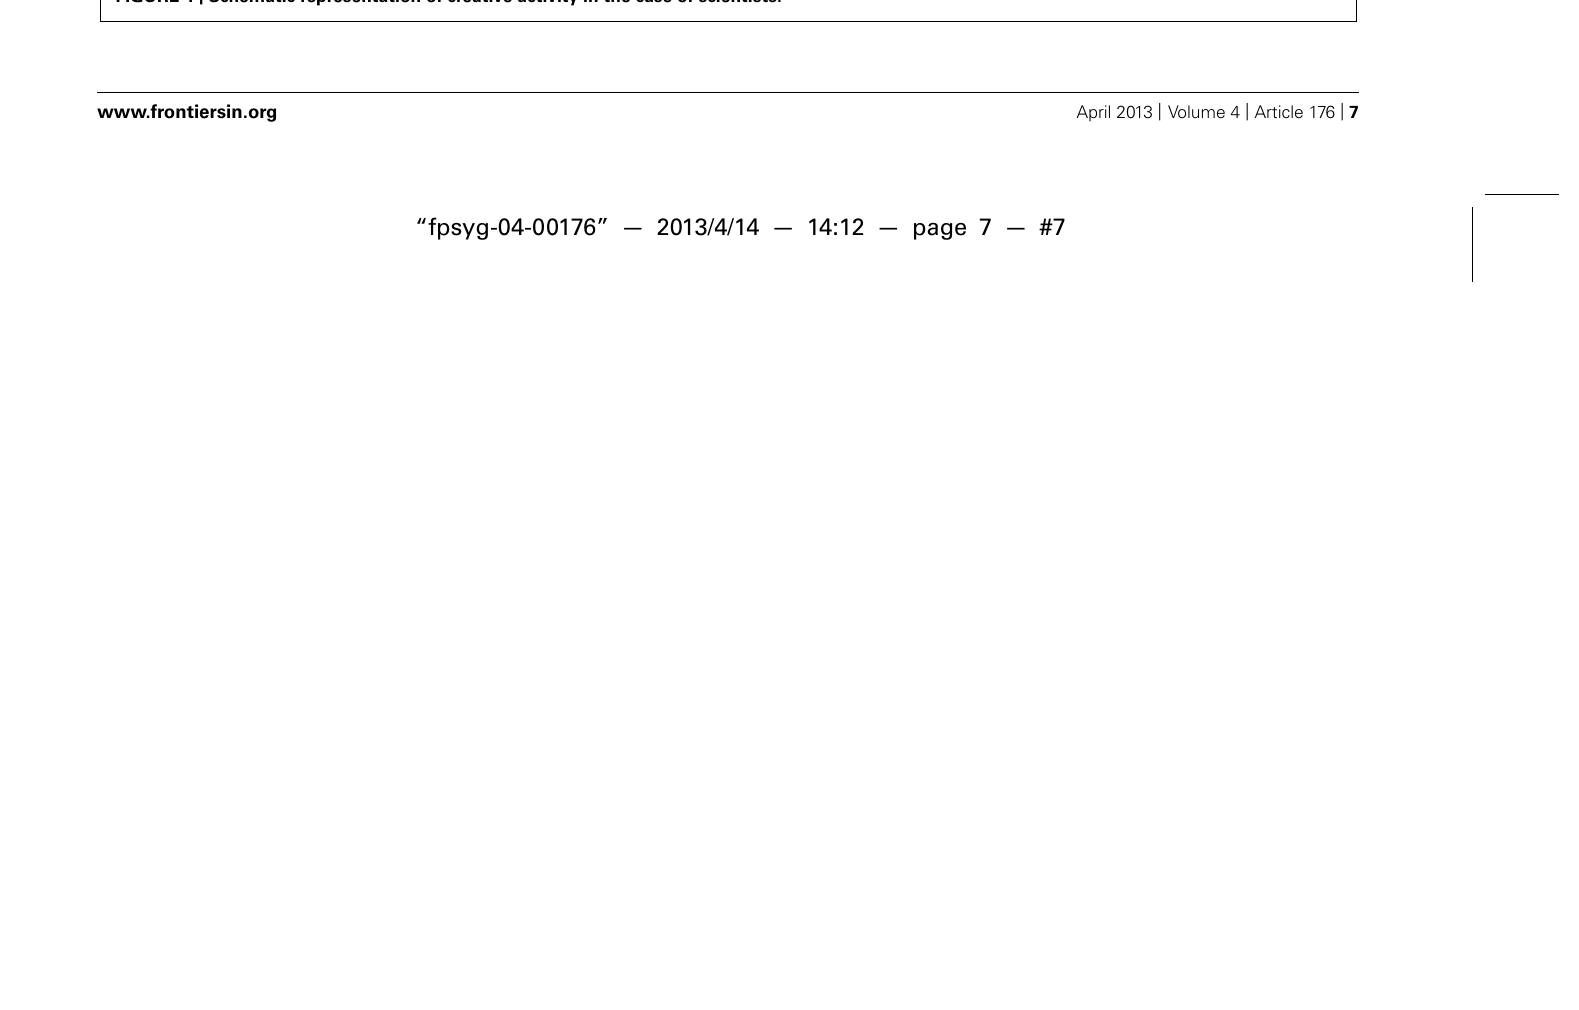
FIGURE 4 | Schematic representation of creative activity in the case of